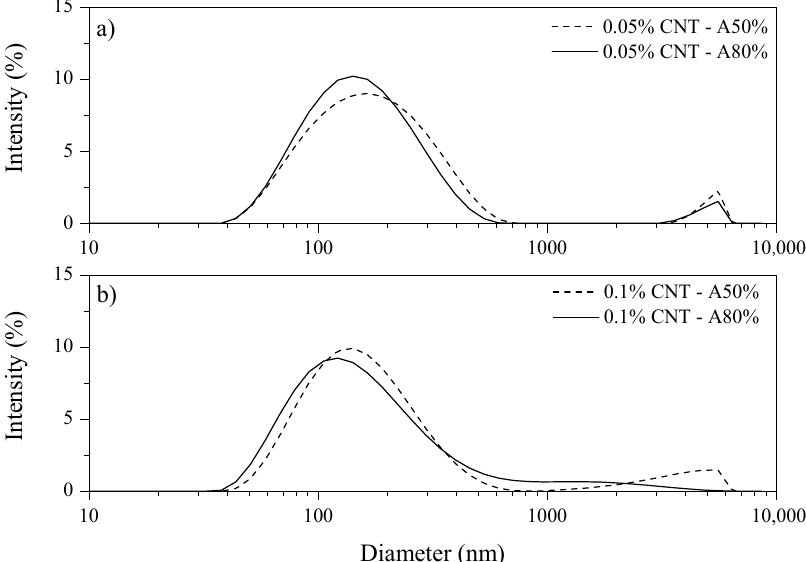
Figure 4. Influence of ultrasonication amplitude on particle size distribution of ( a ) 0.05% CNT and ( b ) 0.1% CNT dispersions. Table 4. Average particle size and polydispersity index (PDI) of CNT